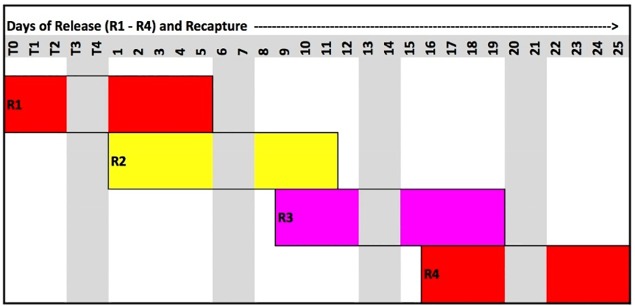
Release and recapture schedule of marked mosquitoes per day of release (R1–4) and recapture, Sítio Novo, Olinda, RMR, Brazil, July 22–August 21, 2015.